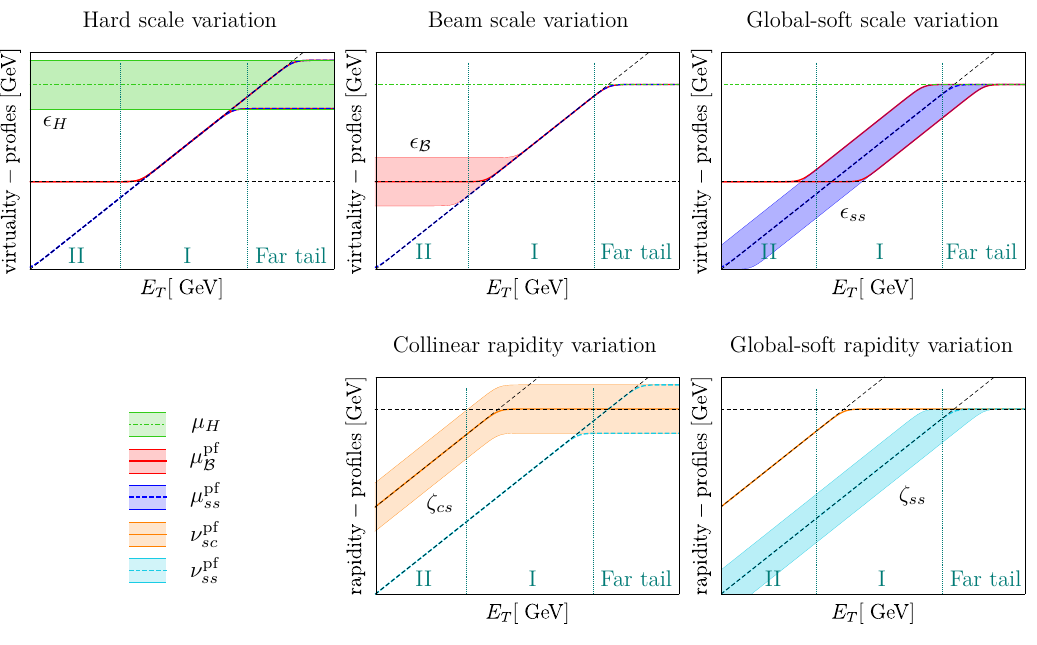
Figure 5 . Illustration of the pro(cid:12)le scales and how each of the four pro(cid:12)le functions changes with the (cid:12)ve scale variations. For improving readability we use log-log plots. parameters to zero and varying the parameter n . We (cid:12)nd that for 4 < n < 12 the result falls within the error bands of the scale variation. We (cid:12)nd that n = 10 gives the best numerical stability for the central values. We do not explore di(cid:11)erent parameterizations of the function g ( (cid:22) 1 ; (cid:22) 2